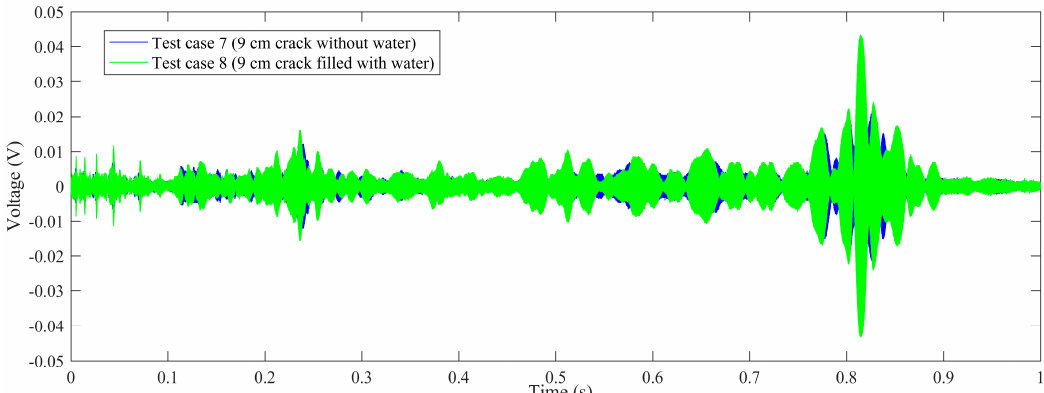
Figure 6. The comparison of voltage signals: test case 3 (5 cm crack without water), test case 4 (5 cm crack filled with water).